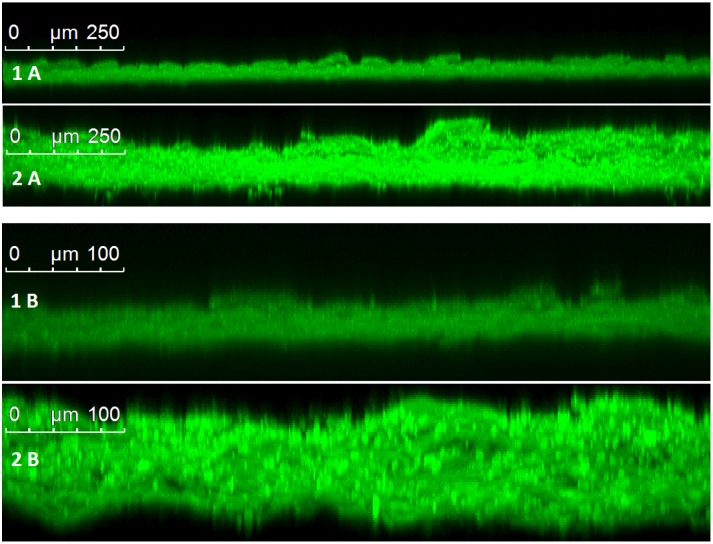
Transverse view of maximum projection images showing the film coat thickness and morphology.Film coat consisting of Kollicoat IR 20% w/w and riboflavin 5’-monophosphate sodium 0.5% w/w as a fluorescent dye. Tablets coated by fluidised bed coating method at defined droplet sizes: 20μm (1) and 70 μm (2). Images were taken at 10x (A) and 25x (B) magnification.